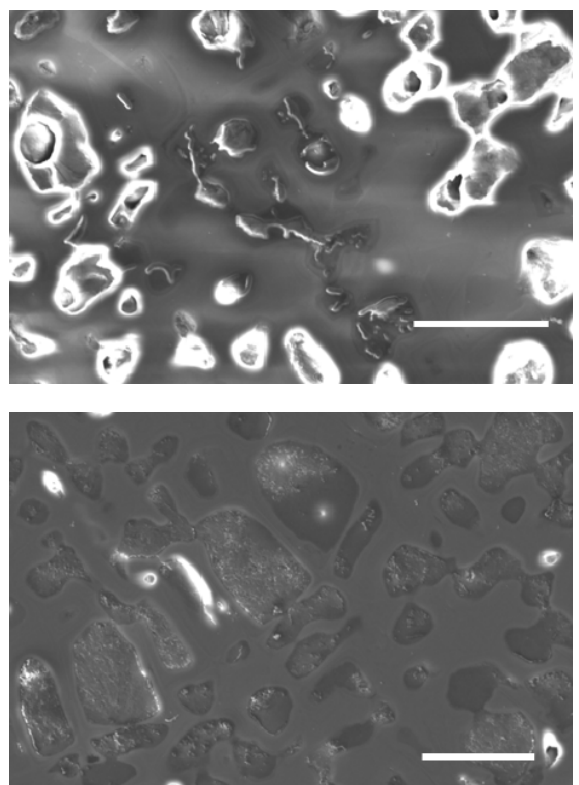
Fig. 6. SEM (SE) images showing the difference in cell in-fill be- tween the top layers and the lower layers of a coralline alga (sam- ple 47). White indicates void of mineral in-fill (caused by charge build-up in sample) and shades of dark grey are in-fill. Top image taken at base of photosynthetically active layer, 0.5mm from top of sample, showing that most cells are empty of mineral in-fill. Scale bar = 25µm. Bottom image taken at 4mm depth, showing abundant cell mineral in-fill. There was a general, although patchy trend for increasing cell in-fill towards the